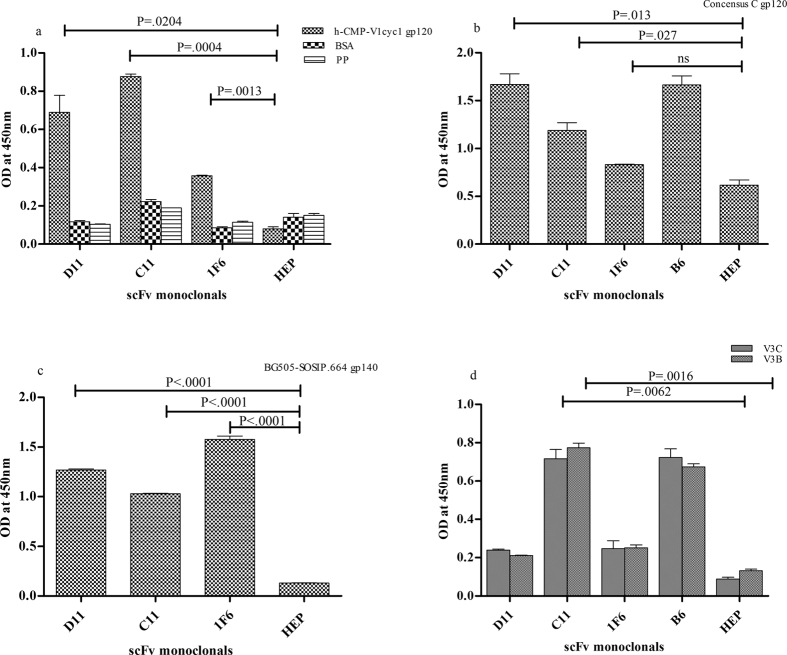
ELISA binding of scFv monoclonals with HIV-1 envelope glycoproteins: ELISA was done to determine binding specificity of the purified scFv monoclonals (at 10 μg/ml concentration) with (a) h-CMP-V1cyc1 gp120 (b) with consensus C gp120 (c) and with trimeric BG505-SOSIP.664 gp140. HEP scFv, the scFv against the hepatitis antigen48 served as negative control for all the assays. (d) ELISA binding reactivity of scFv monoclonals (at 10 μg/ml concentration) with V3C and V3B peptides was tested. B6, an anti-V3 scFv generated in our lab earlier (unpublished data), is used as positive control. Mean binding titres were compared with negative control using un-paired t test. P values < 0.05 were considered as significant.